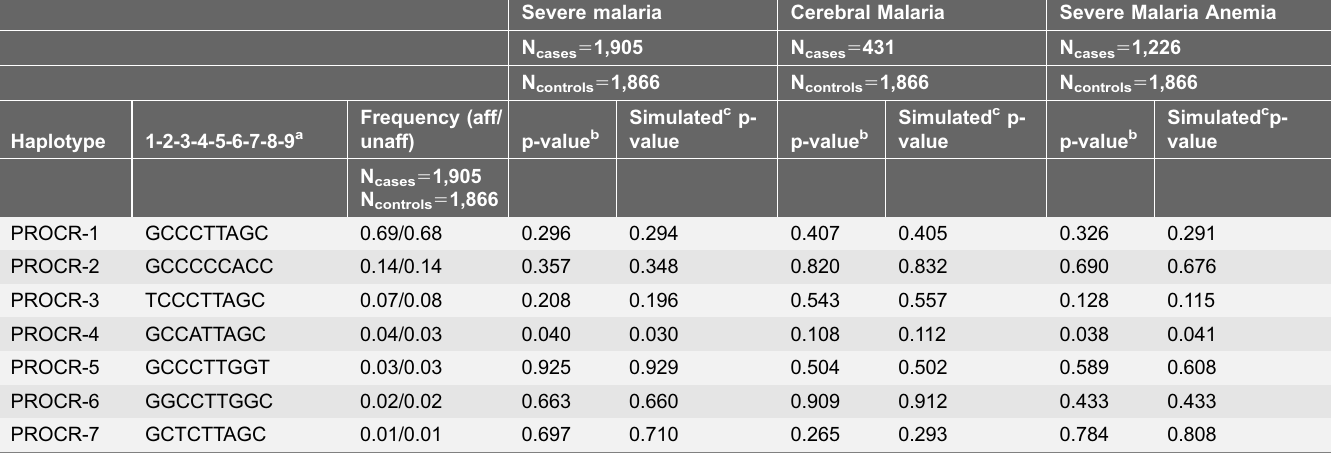
Table 3. Association tests of PROCR haplotypes with severe malaria, cerebral malaria, and severe malaria anemia.